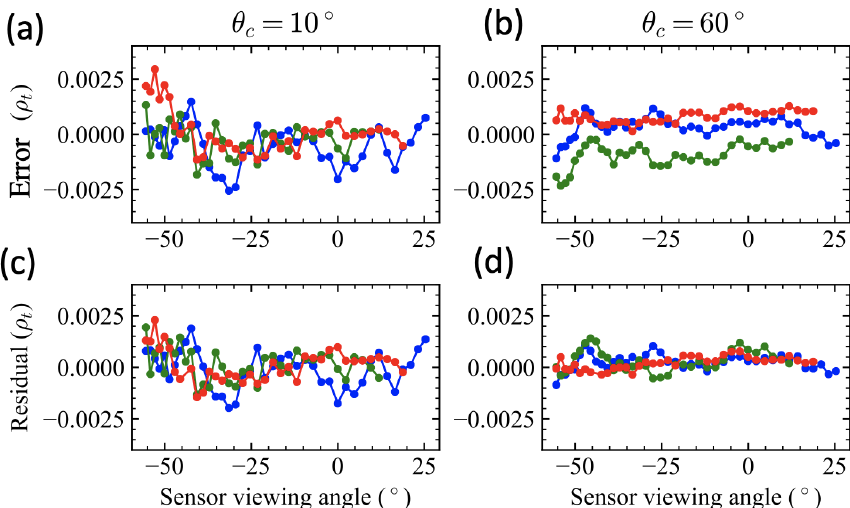
Figure 2. Examples of simulated measurement errors generated for reflectance at the 660nm band with a correlation angle of 10 ◦ (a) and 60 ◦ (b) , respectively. The fitting residuals are shown in panels (c) and (d) . A total of 1000 sets of errors are generated and added to the simulation data. Three sets of error examples are shown in different colors. The right side of viewing angle ends around 25 ◦ due to the removal of sunglint as shown in Fig.